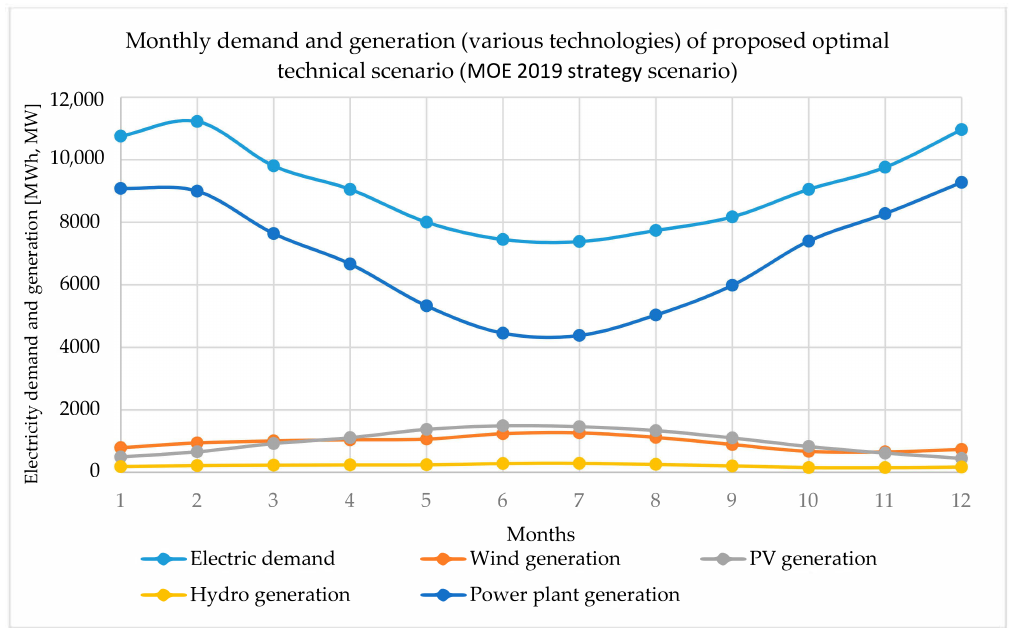
Figure 13. Monthly demand and generation (various technologies) of the proposed optimal technical scenario (MOE 2019 strategy